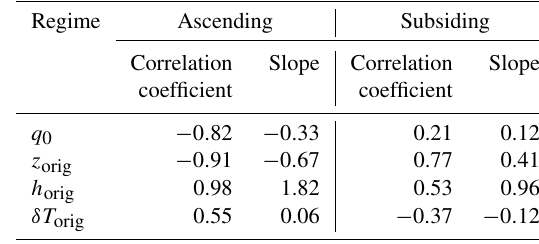
Table 4. Decomposition of the spatial-seasonal variation in r orig into its four contributions: effect of q 0 , z orig , h orig , and δT orig vari- ations. For each contribution, we show the correlation coefficient of the linear regression of the contribution as a function of r orig . The analysis is performed separately for ascending and subsiding regimes. All seasons and locations over tropical oceans (30 ◦ N– 30 ◦ S, ocean fraction > 80%) are considered. The threshold for the correlation coefficient to be statistically significant is 0.15 or lower in all cases. We write correlation coefficient and slope values be- tween brackets when they are not significant at 99%.